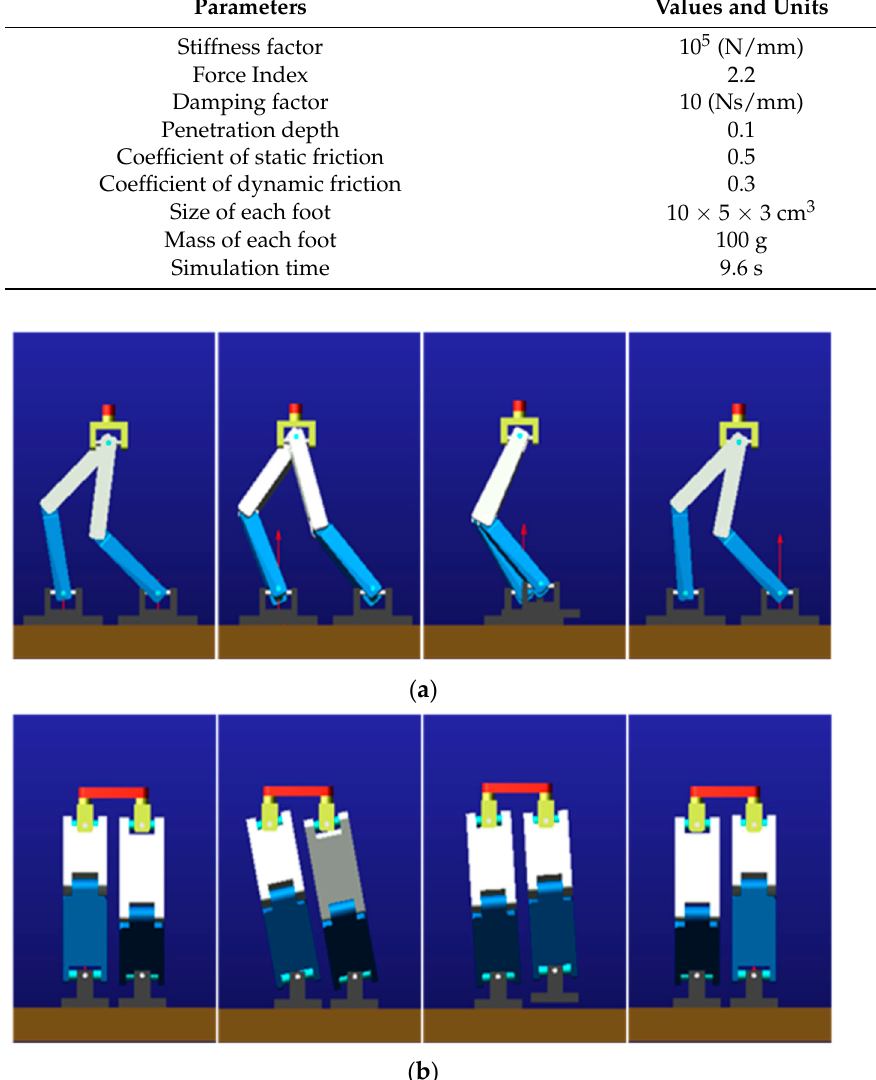
Figure 1. Kinetic simulation keyframes: ( a ) forward plane and ( b ) lateral plane